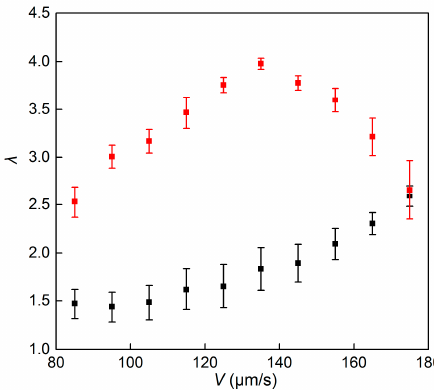
Figure 11. Distribution of ln[ f ( V, θ )]: ( a ) ln[ f ( V, θ )] versus V and cos θ , ( b ) ln[ f ( V, θ )] versus cos θ for given V .